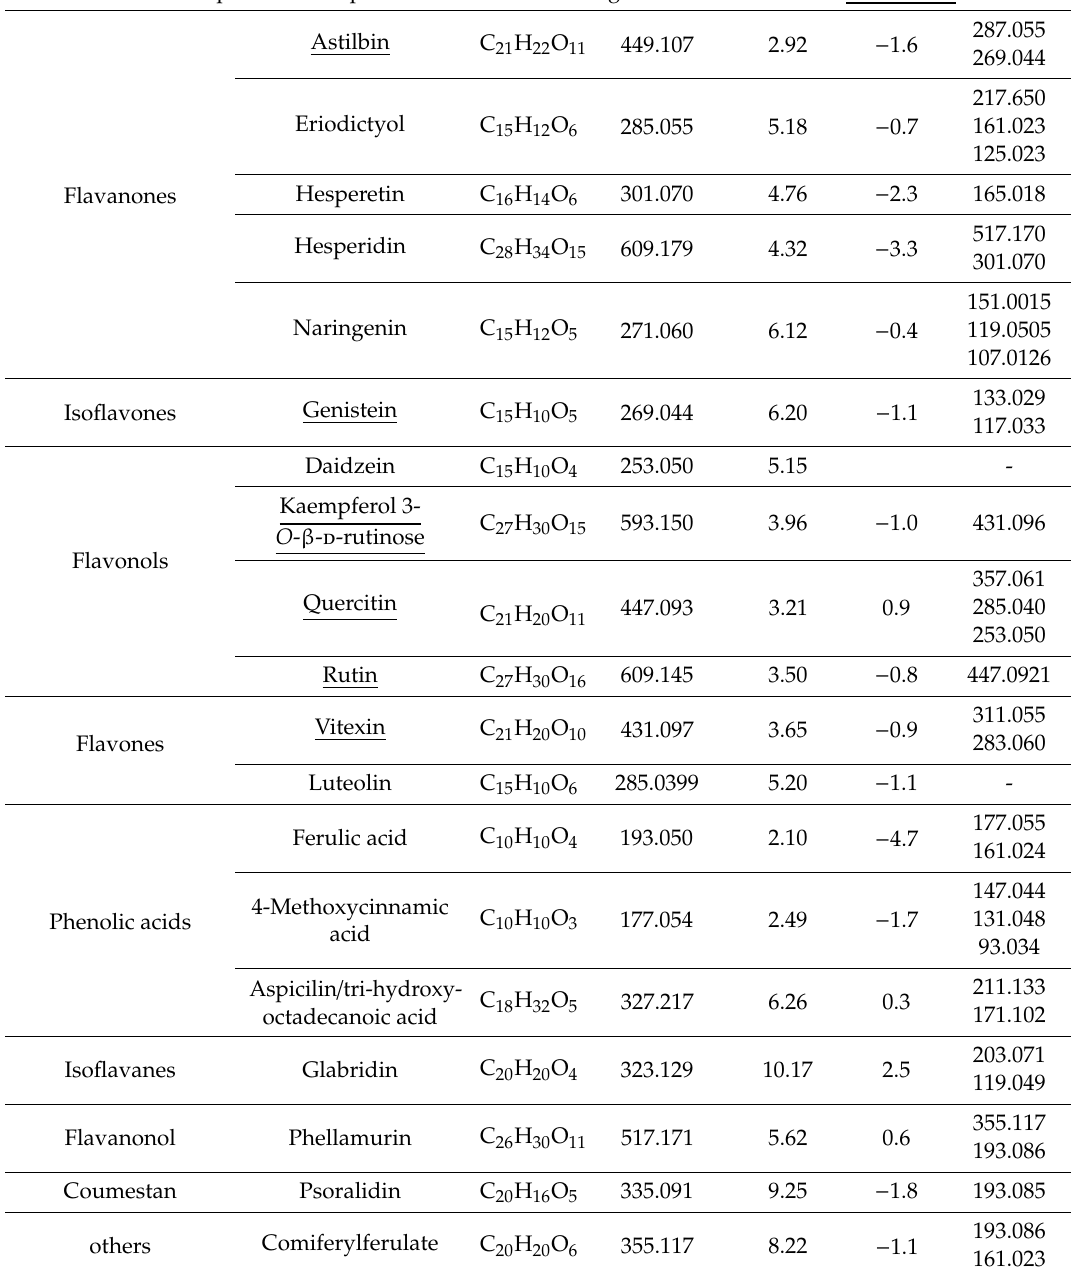
VRG3D: Phenolic Compounds in 3-Day-germinated Mung Bean